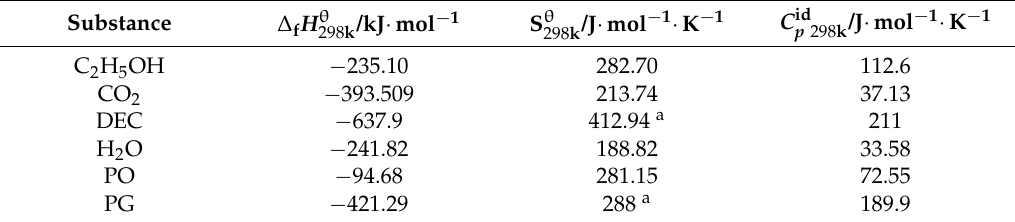
Table 2. Thermodynamic data of various substances in the reaction [26].